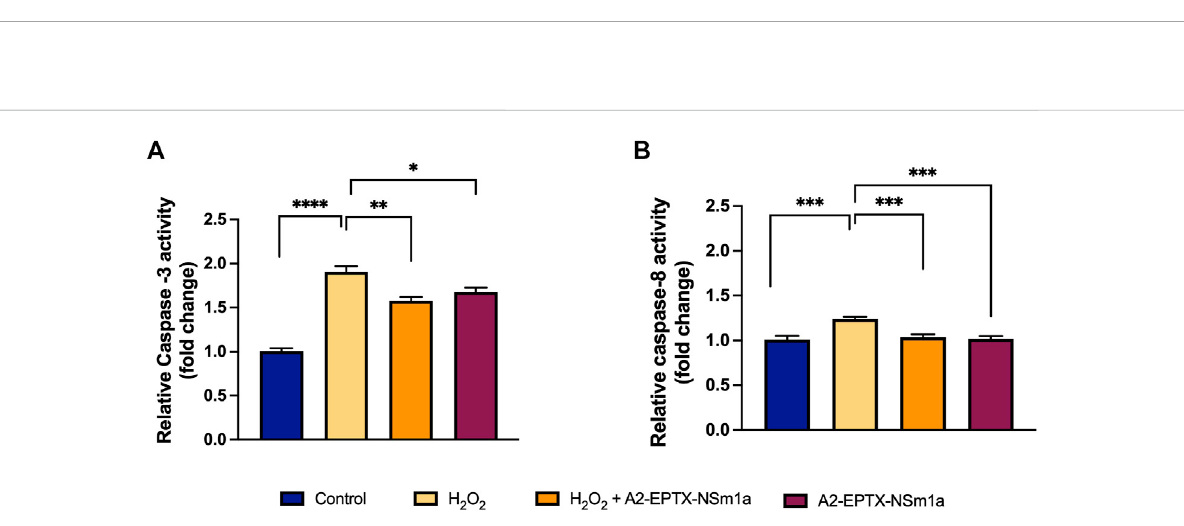
FIGURE 3 Effect of pre-challenged A2-EPTX-NSm1a on caspase-3 and caspase-8 activity in differentiated SH-SY5Y with H 2 O 2 . (A) Relative Caspase-3 activity(fold change); (B) RelativeCaspase-8 activity(fold change)All experiment was conducted intriplicate ( n = 3).Data arepresentedas themean ± SD. * p < 0.05, ** p < 0.01, *** p < 0.005, **** p < 0.001 as compared to the H 2 O 2 -treated